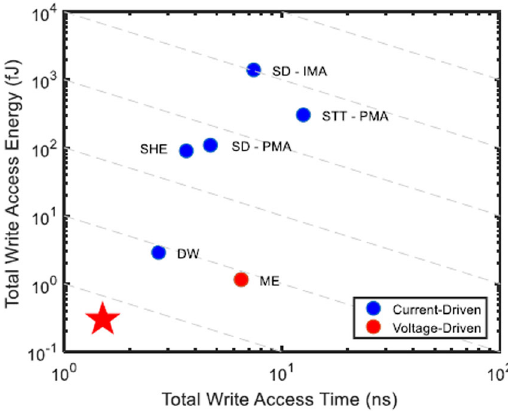
Fig. 2 Performance estimates, writing energy vs time, for various spintronic memory cells. SD: spin diffusion, STT: spin-transfer torque, SHE: spin Hall effect, DW: domain wall motion, ME: magnetoelectric switching, IMA: in-plane magnetic anisotropy, PMA: perpendicular magnetic anisotropy. A red star designates the preferred corner (2017 IEEE, reprinted, with permission from ref. 10